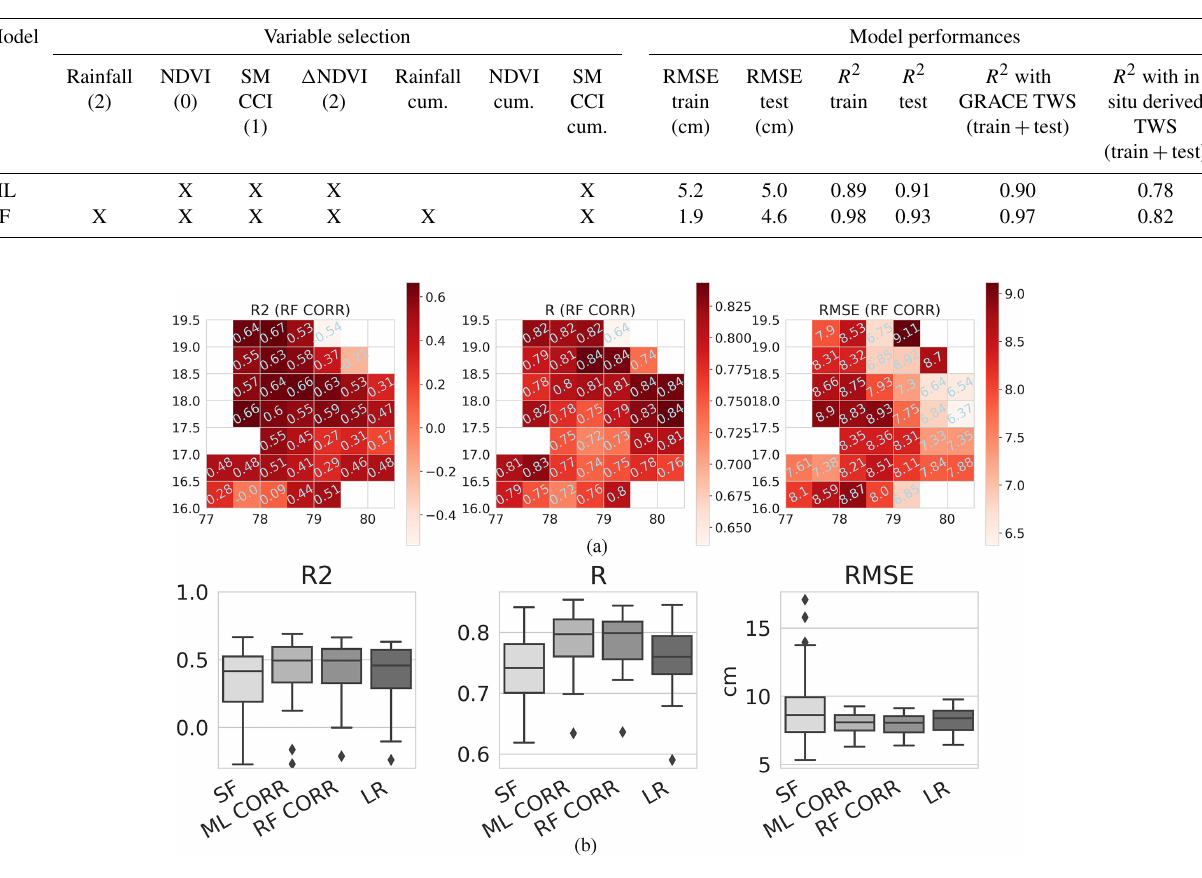
Figure 4. (a) Spatial distribution of R 2 , R , and RMSE for the downscaling with the random forest model with bias correction (RF CORR). The numerical value of the metric is indicated in the grid. The abscissa is the east longitude and the ordinate the north latitude. (b) Boxplot (median and quartiles) of R 2 , R , and RMSE between GWS-OW and the scaling factor product (SF), linear (ML), and random forest (RF) model-downscaled products with bias correction (CORR) and the low-resolution reference GWS-LRref (LR). The RMSE is an equivalent water height in